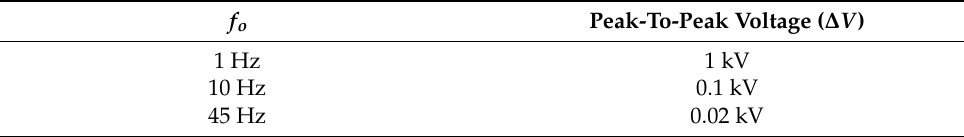
Figure 5. MMC simulation results. ( a – c ) show the phase-A-upper-arm insertion-index signal ( S ( t ) ) for the cases in which f o = 1,10 and 45 Hz, respectively. ( d – f ) show the phase-A-upper-arm current ( i arm ) for the cases in which f o = 1,10 and 45 Hz, respectively. ( g – i ) show the phase-A upper-arm submodule-capacitor voltages ( v cap ) for the cases in which f o = 1,10 and 45 Hz, respectively. Table 1. MMC submodule capacitor voltage